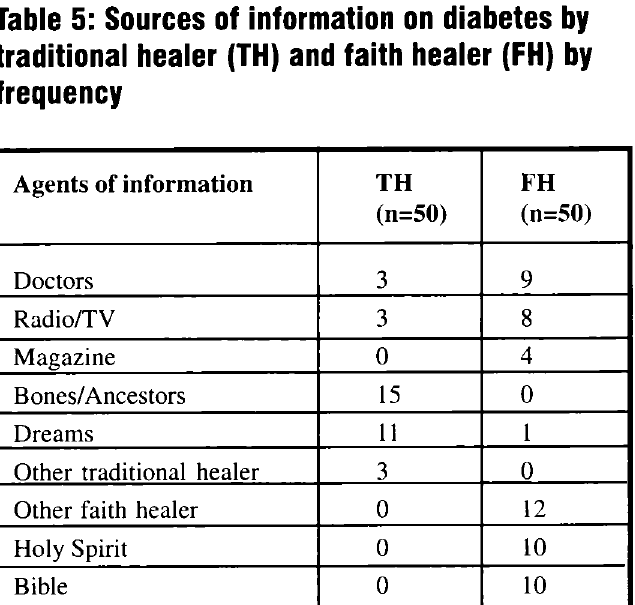
Table 5: Sources of information on diabetes by traditional healer (TH) and faith healer (FH) by